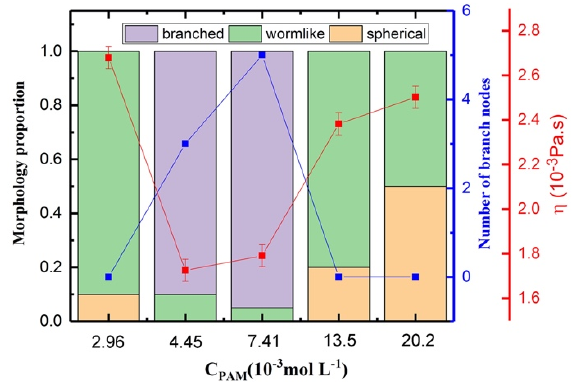
Figure 12. Results of the morphology proportion, number of branch nodes, and viscosity as a function of PAM concentration.